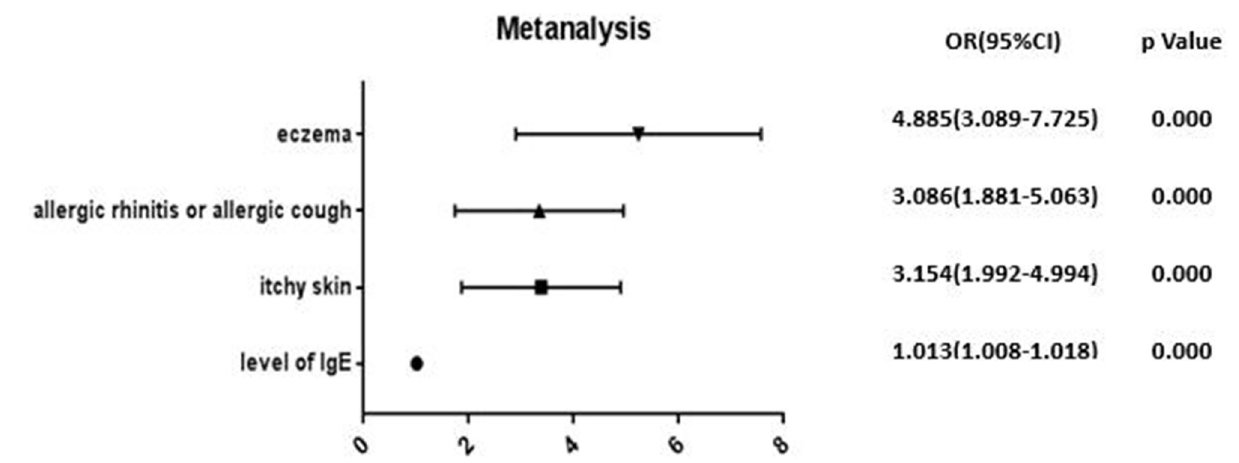
FIGURE 1 | Binary logistic regression analysis of the risk factors in children with OAB.